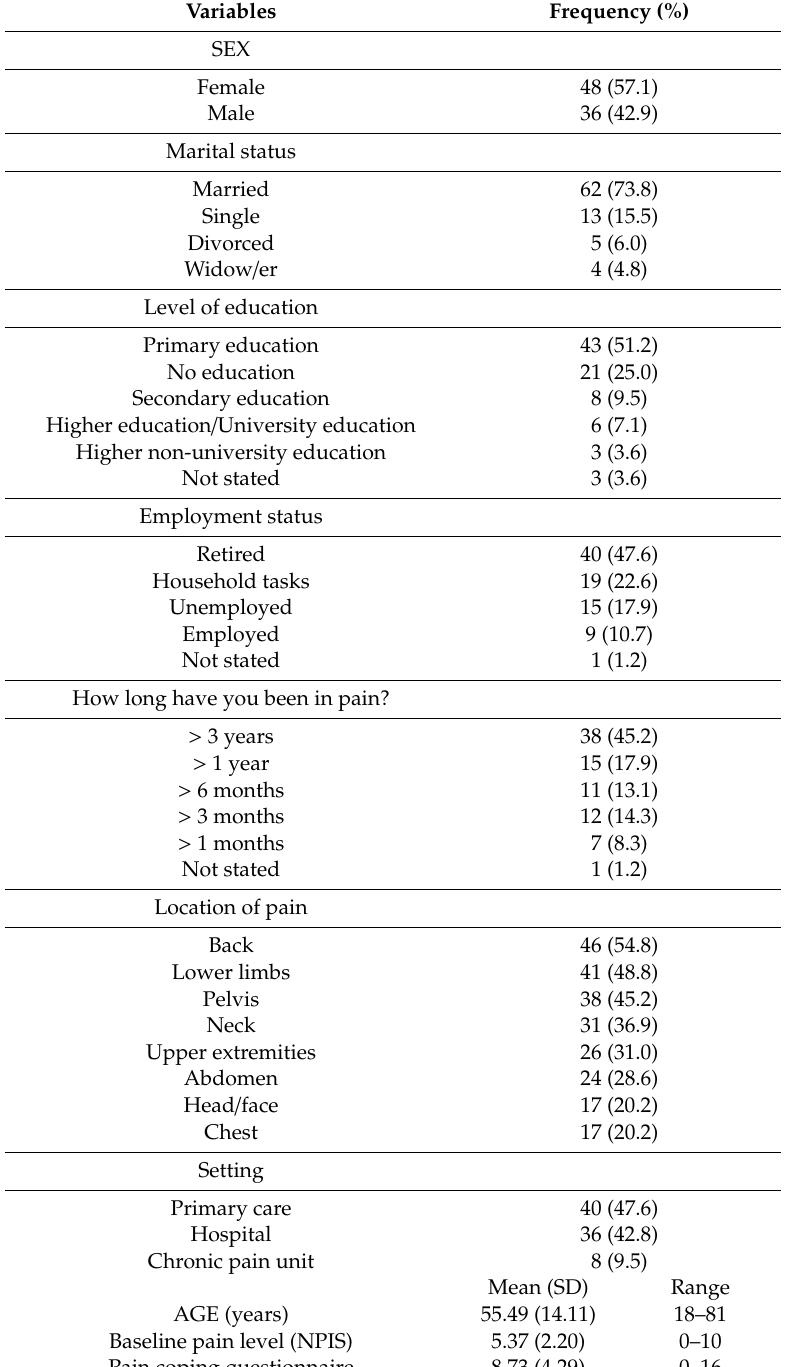
Table 3. Characteristics of patients assessed with Knowledge: Pain management ( N =